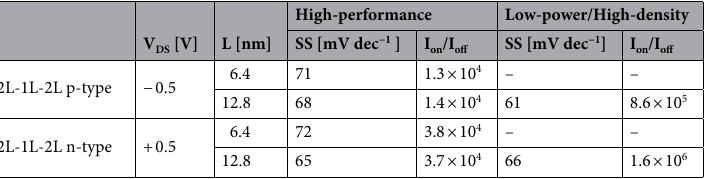
Finally, using the “AbInIM” approach presented above, we also assessed the performance of p-type (n-type) 2L-1L PtSe need to be optimized towards either high-performance (HP) or low-power/high-density (HD) applications. The current in the off state must satisfy I off = 10 –2 A m −1 for HP applications, while a lower I off is required, I off = 10 –4 A m −1 , for HD applications. In each case, we define V off as the gate voltage for which I DS = I off . We consider two different channel lengths, namely 6.4 nm and 12.8 nm. We fix the valence (conduction) band edge for the p- (n-) type FETs, 0.05 eV above (0.15 eV below) the electrochemical potential in the source and drain, which provides charge neutrality far from the heterointerfaces for a souce and drain acceptor doping of 4 × 10 12 cm −2 (donor doping of 3 × 10 13 cm −2 ). The obtained transfer characteristics for all cases are reported in Supplementary Figure S2, and the SS and I on /I off ratio estimated for HP and HD digital applications are reported in Table 1. We find that the considered LH-FETs can reach very good SS in the range 61–72 mV dec −1 and ratios I on / I off > 10 4 for the HP optimized cases, which increases above 10 5 in the HD ones. The longer channel benefits from lower SS, near the optimum 60 mV dec −1 , enabling for HD applications, contrary to the shorter channel, where tunnelling yields a relatively large current in the sub-threshold regime. We also find no significant differences in performance between p- and n-type FETs for HP applications, whereas the p-type FET clearly outperforms the n-type for HD applications, yielding almost an order of magnitude improvement for both SS and I on / I off ratio. Charge transport in 4L-1L PtSe LH-FET with sharp and smooth interfaces. A relevant advan- 2 tage of the method presented in this work is that it enables to model LHs with non-ideal interfaces. In the pre- vious section we have seen the importance of mapping atomic interface details in a situation where small-gap semiconducting leads of 2L PtSe 2 are attached to the larger-gap 1L channel. We now move to analyze a 4L-1L LH of PtSe 2 , where interfaces present the additional degree of freedom of allowing for smooth junctions in the form of slightly tilted 4L-1L interfaces (see Fig. 5a). As a first approximation we decided not to undertake a rigorous study of the actual structural stability of the exposed edges of the 4L regions. As for the 2L-1L structures, we have ensured Se terminations to minimize in-plane electric fields across the 1L region, and we have relaxed the positions of all edge Se atoms until residual forces were below 10 –3 Ry/Bohr. Contrary to other state-of-the-art approaches, atomic-scale details on the channel-lead barrier can now be accounted for in the transport simula- tions, with the additional advantage of keeping the computational cost down to that required for a perfectly sharp junction. All details regarding the construction and validation of the MLWF Hamiltonian for the 4L-1L PtSe 2 LH are reported in the Supplementary Information. Hereafter we report on the performance prediction of a double- gated 4L-1L PtSe 2 LH-FETs far from equilibrium, and the variations associated to the ab-initio modelling of the sharp and smooth interfaces. To this end we simulate the transfer characteristics of the device shown in Fig. 5b, with semi-infinite 4L leads and a 6.4 or 12.8-nm long 1L channel. Since the 4L system is metallic, transport is ambipolar. We apply a drain-to-source bias voltage V DS = 0.5 V and scan over both positive and negative top/ bottom gate voltages V GS , corresponding to electron and hole transport, respectively. For all devices, the top/ bottom gates are long as the channel and the dielectric layers (namely SiO 2 ) separating the channel from the gates have an equivalent oxide thickness of 0.5 nm. The curves obtained for the 6.4 nm channel length are shown in Fig. 5c. The off-state current I off in this case is always larger than 10 –4 A m −1 for any applied V GS , due to intraband tunnelling which dominates transport across such a short channel, therefore we only assessed the performance of this particular device for HP applica- tions. The E on-site profiles and band diagrams at V GS = 0 and V DS = 0.5 V for the LH with 12.8-nm long channel are illustrated in Fig. 5d,e, for both sharp and smooth interfaces. The calculated transfer characteristics, optimized for both HP and HD applications, are shown in Fig. 5f,g. The main figures of merit, namely the SS and the I on / I off ratio, for both HP and HD process optimizations are extracted and reported in Table 2, for all the modelled devices. We find that these do not differ significantly from the values obtained for the 2L-1L LH-FETs, reported in Table 1. Furthermore, we observe that a 3-nm smooth interface between 1 and 4L regions, rather than an atomically sharp one, does not alter the performance of LH-FETs significantly. This is especially true for the n-branch of the transfer characteristics, with only few differences in the p-branch for V GS above a certain thresh- old, namely V devices with sharp or smooth interfaces are slightly different (see Supplementary Figure S4), yielding a Schottky barrier for holes which is 0.1 eV lower in the sharp case compared to the smooth case.